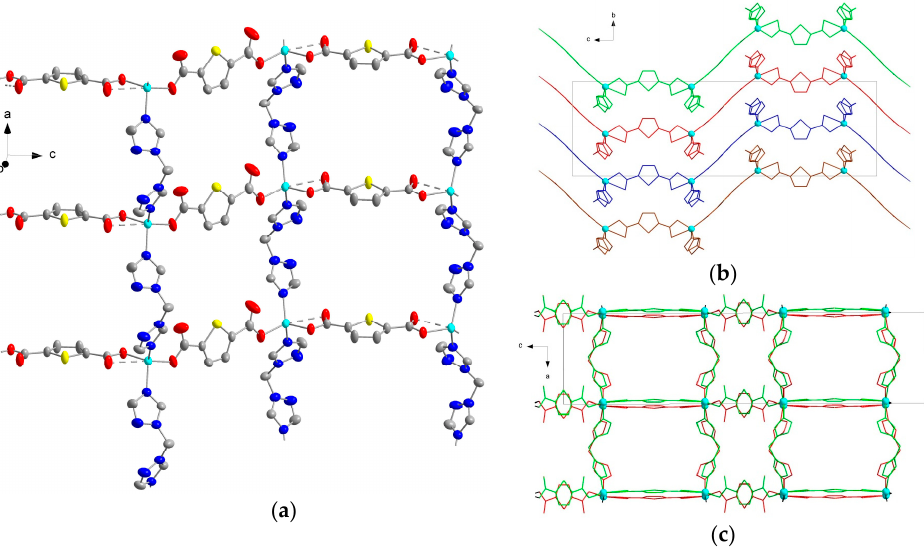
Figure 2. ( a ) Displacement ellipsoid plot of complex [Zn(tdc)(btrm)] ∙ nDMF ( 1 ) showing 50% probability ellipsoids. H atoms are not shown for clarity. Dashed lines indicate long-range Zn ∙∙∙ O interactions. ( b , c ) Relative arrangement of the layers of 1 colored green, red, blue, and brown.